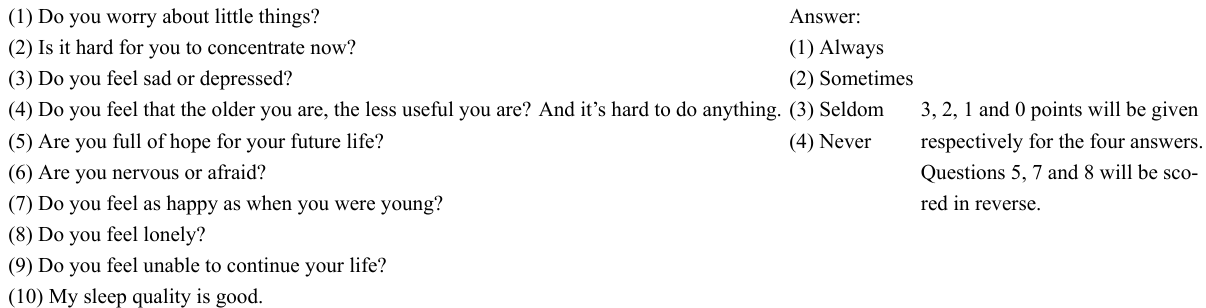
Table 6. 10 questions regarding participants experience during the past week, up to two weeks (CES-D-10). (1) Do you worry about little things? Answer: